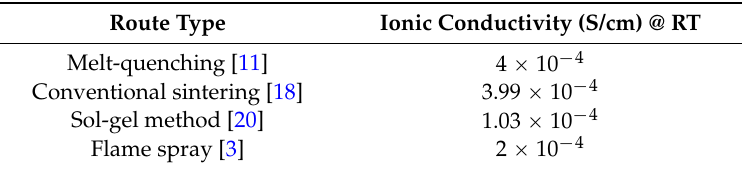
Table 1. Selected lithium aluminum germanium phosphate (LAGP) ionic conductivities values obtained via different